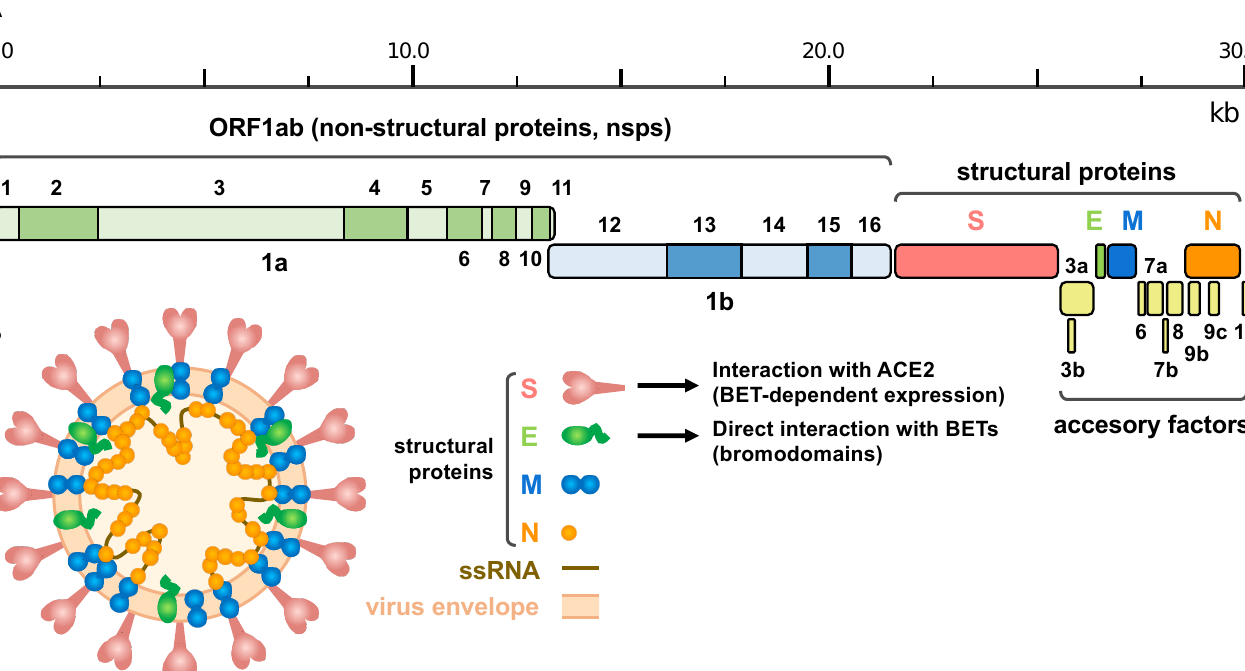
Figure 2. SARS-CoV-2 genomic structure and proteins. ( A ) Schematic representation of the SARS-CoV-2 genome, indicating the different derived proteins. ORF 1ab give rise to two polyproteins for non-structural proteins: pp1a and pp1ab, this last through a programmed ribosomal frameshift. Structural proteins comprise: Spike (S), Envelope (E), Membrane (M) and Nucleocapsid (N) proteins. ( B ) Schematic representation of the viral particle showing the viral envelope, the single strand RNA (ssRNA) genome and structural proteins (proteins are not represented to scale). Interaction of S protein with ACE2 (under the control of BET proteins) and direct interaction of E protein with BETs (putatively involving the bromodomains) is also indicated.